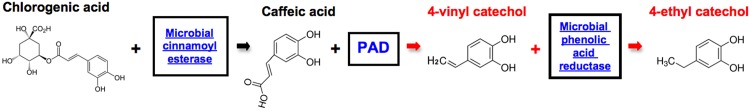
Model for multi-step bioconversion of inactive dietary precursors to Nrf2 activators by Lactobacillus collinoides.Microbial cinnamoyl esterase from L. collinoides converts chlorogenic acid (inactive) to caffeic acid (inactive), thereby providing substrate for phenolic acid decarboxylase (PAD)-mediated generation of 4-vinyl catechol (Nrf2 activator). Finally, microbial phenolic acid reductase, also expressed by L. collinoides, reduces 4-vinylcatechol to 4-ethylcatechol (Nrf2 activator). See text for supporting references and subsequent figures for supporting data.